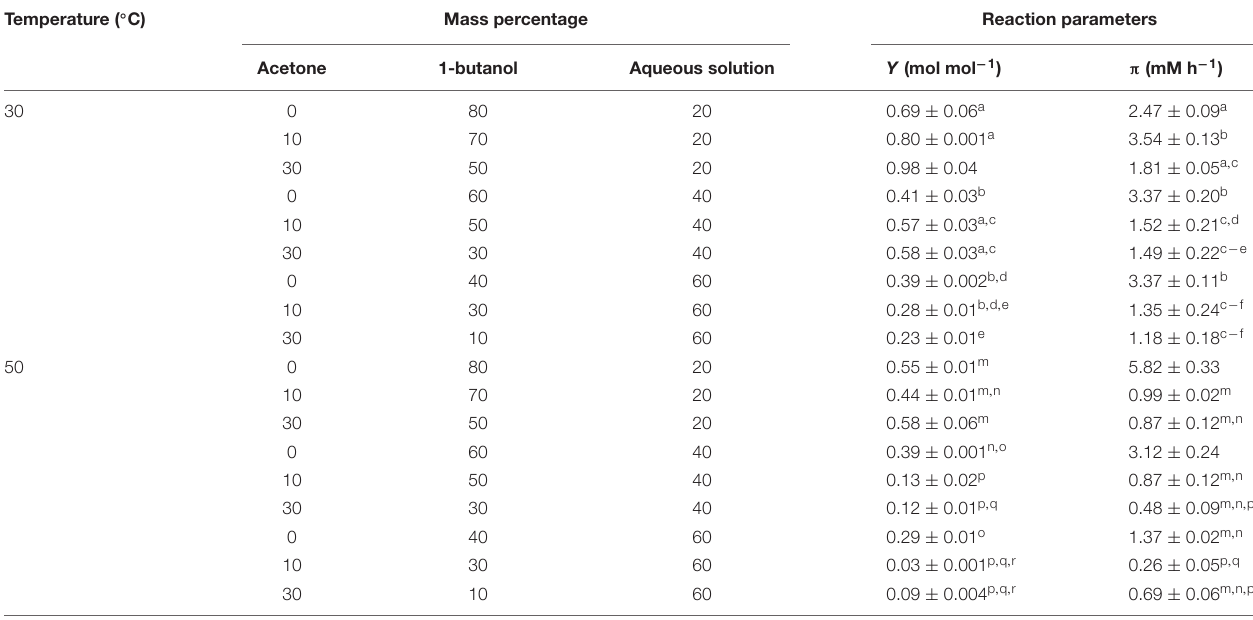
TABLE 1 | Product yield ( Y ) and productivity ( π ) of butyl- β -galactoside synthesis with soluble β -galactosidase from A. oryzae in acetone/1-butanol/aqueous solution ternary system. Temperature ( ◦